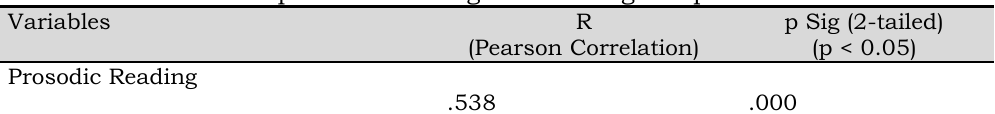
Table 5. Correlation of prosodic reading and reading comprehension achievement